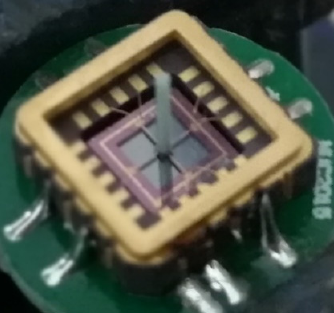
Figure 13. Secondary integration of cilium and central block.